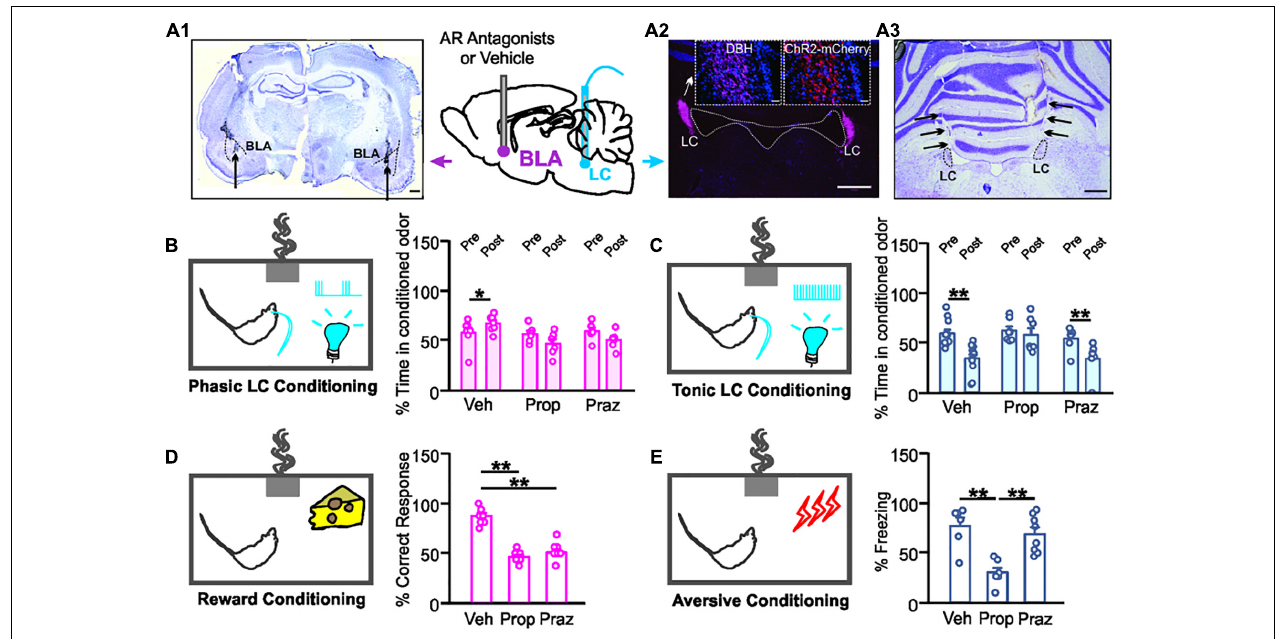
FIGURE 1 | Distinct adrenoceptor requirement for odor valence learning. (A1) Example image of bilateral basolateral amygdala (BLA) cannula implantation targeting. Dashed lines outline BLAs. Arrows indicate cannula tips. Scale bar, 500 µ m. (A2) ChR2-expressing mCherry cells in the locus coeruleus (LC) co-localize with dopamine beta-hydroxylase (DBH) positive cells. Scale bars, 500 µ m and 50 µ m (insets). (A3) Example image of bilateral optical cannula tracks targeting LCs (black arrows). Scale bar, 500 µ m. (B) Time spent in the conditioned odor pre- and post- odor associative training with 10 Hz phasic LC photo-activation. (C) Time spent in the conditioned odor pre- and post- odor associative training with 25 Hz tonic LC stimulation. (D) Percentage correct response toward the rewarded odor during the testing. (E) Percentage time spent freezing upon the odor exposure during the testing. Veh, vehicle; Prop, propranolol; Praz, prazosin. * p < 0.05, ** p <